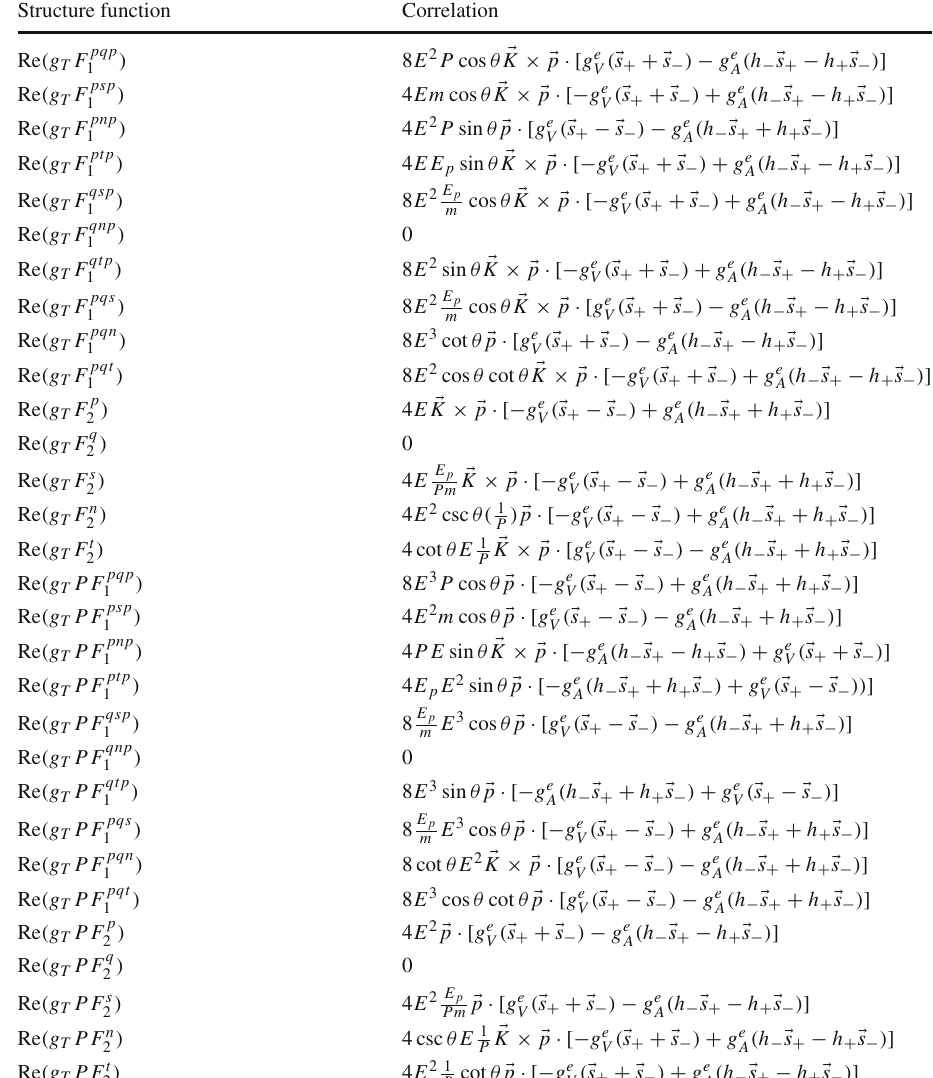
Table 3 As in Table 1 for real Structure function parts of the tensor couplings